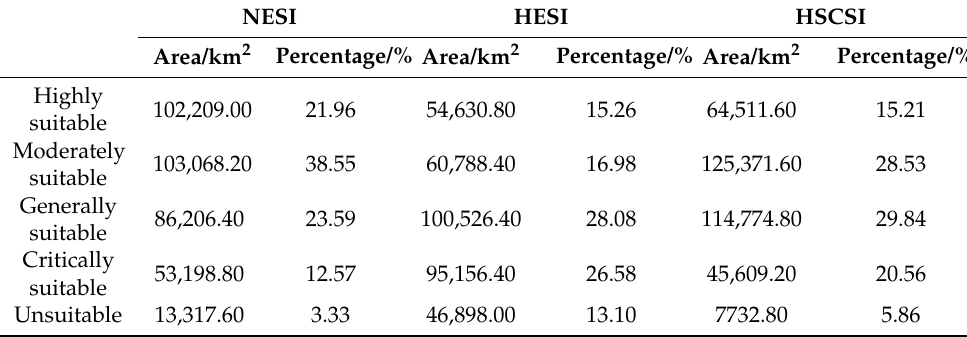
Table 4. Zoning statistics of human settlements suitability in the